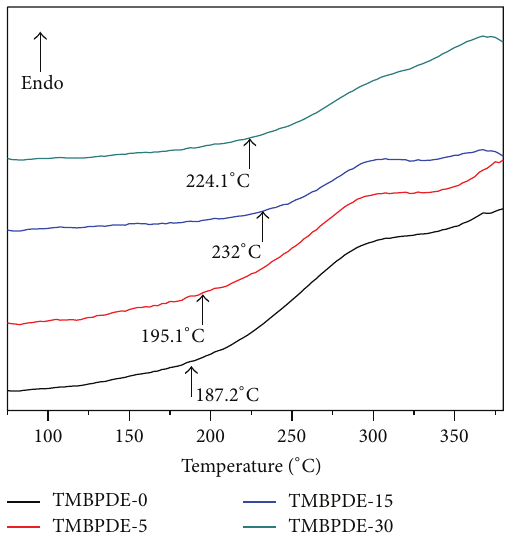
Figure 7: The glass transition temperatures of UFUR/TMBPDE composite resins with different TMBPDE contents.